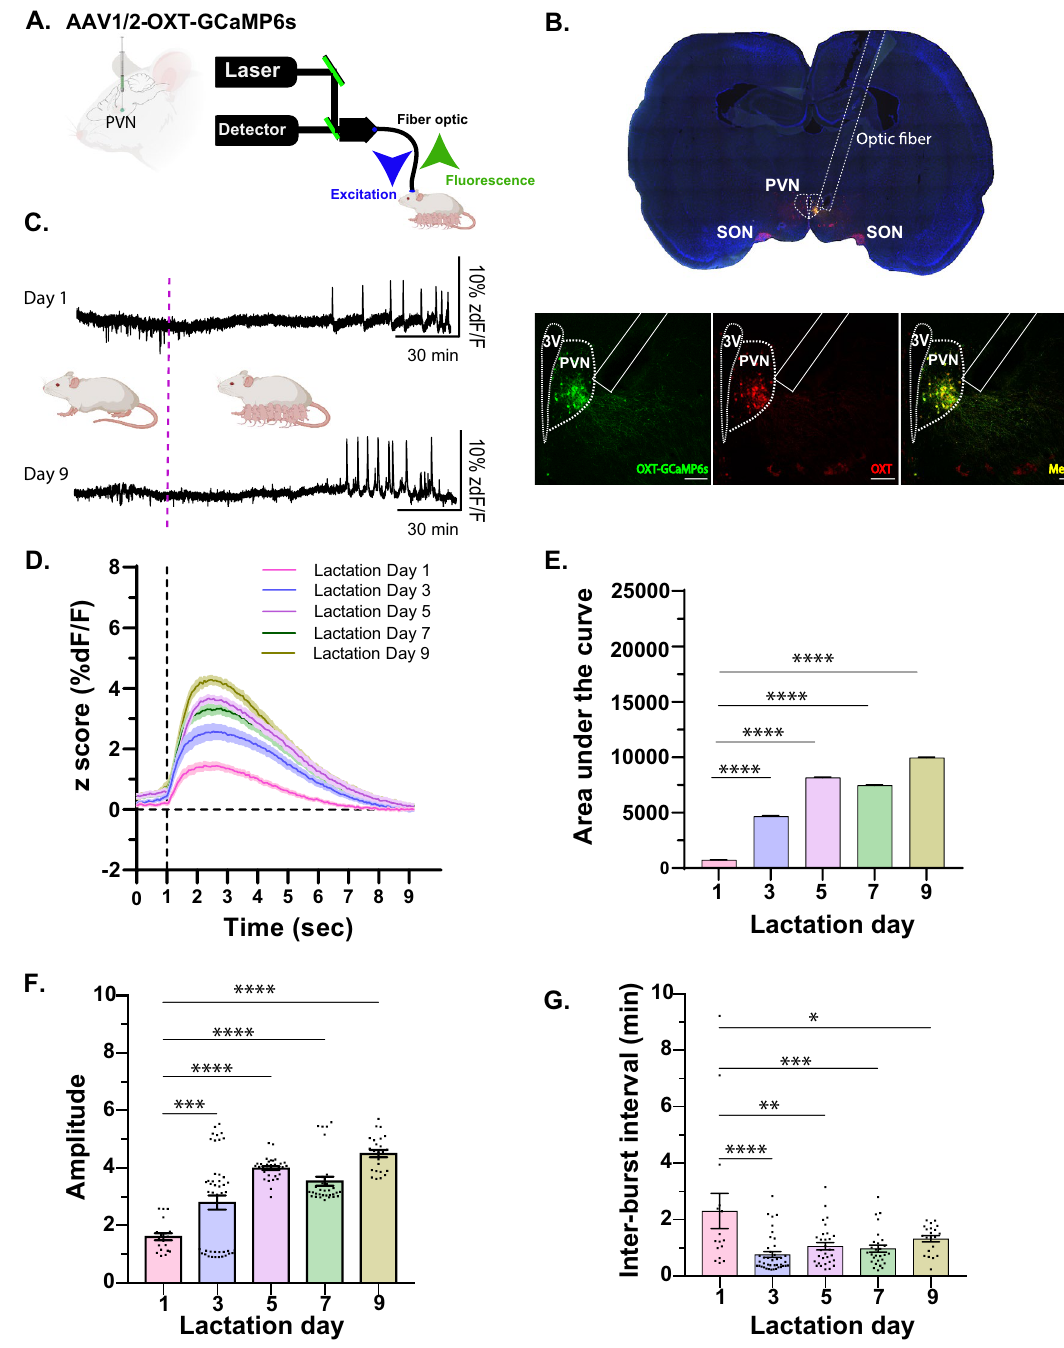
Figure 4. Amplitude and frequency of OXT neural response dynamics over time and across days of lactation. ( A ) A schematic showing viral injection of the AAV1/2-OXTp-GCaMP6s viral injection and the fiber photometry set up. ( B ) Tiled image (top) of a rat coronal section shows the position of the optic fiber relative to OXT neurons within the PVN. Bottom image shows GCaMP6s (left, green), whose expression is under the control of the OXT promoter, OXT labeling using anti-OXT antibodies (middle, red), and the overlap between the two (right, yellow), demonstrating the specificity of the virus. Scale bar = 100 μm. ( C ) Representative traces of OXT neurons activity (%zdF/F), recorded on days 1, 5, 7 and 9 of lactation from the PVN of lactating rat. Dotted magenta line indicates when pups were re-introduced to the lactating rat. ( D ) Average lactation-dependent GCaMP6s responses of PVN-OXT neurons across days. Each day represents average responses from 3 female rats during lactation (10–17 bursts per rat). ( E ) Area under the curve was calculated from average lactation-dependent responses across days. ( F ) Amplitude of lactation-dependent response increases over lactation days. ( G ) Inter-burst intervals of lactation-dependent response, is highest on day 1 of lactation (Day 1), reflecting lower frequency and increases on Day 3, reflecting an increase in frequency, which remains consistently the same across consequent days of lactation. 3 V, 3rd ventricle, PVN, Paraventricular Nucleus; SON, Supraoptic Nucleus. Z score (zdF/F), z scored change in GCaMP6s-dependent response over non-GCaMP6s-dependent response. *p < 0.05, **p < 0.005, ***p < 0.0005. Part of A and C were created with https:// BioRe nder.